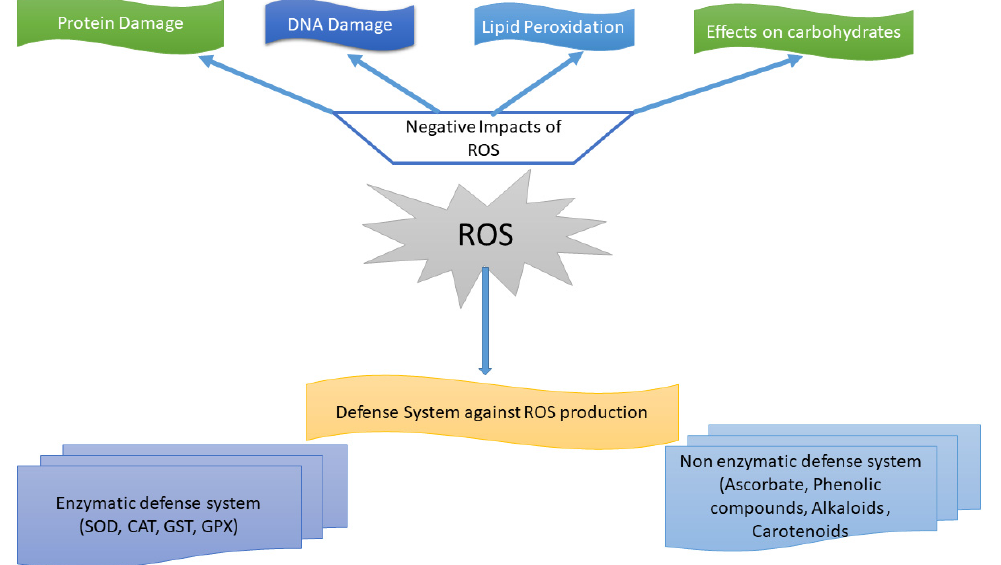
Figure 2. Effects of oxidative stresses on plant parts and different defense mechanisms. In plants, ROS cause serious damage to the cells by inhibiting proteins, DNA and other metabolic pathways. Conversely, the defense system is activated in the plants against ROS to regulate its functional activity by activating different enzymatic and non-enzymatic antioxidant agents.